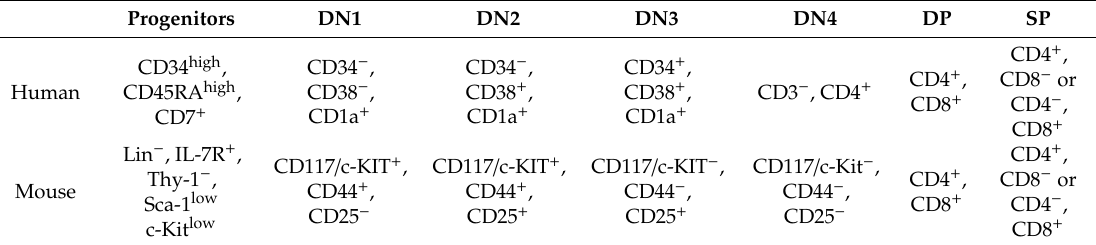
Table 3. Surface antigen markers of T-cell development in humans and